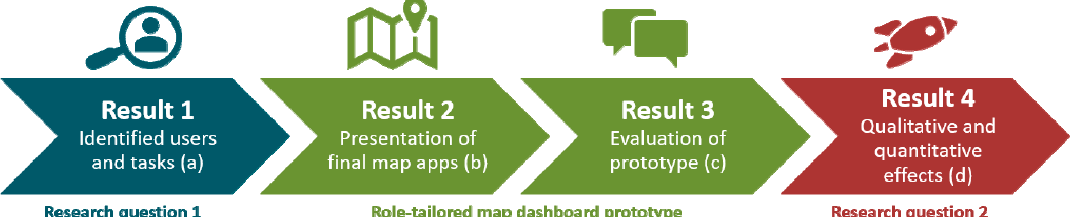
Figure 4. The four results with regard to the research questions: ( a ) the identified major roles and tasks, ( b ) some of the final web mapping prototypes, ( c ) evaluation of the prototype, and ( d ) the qualitative and quantitative effects of the role-tailored map dashboard prototype.